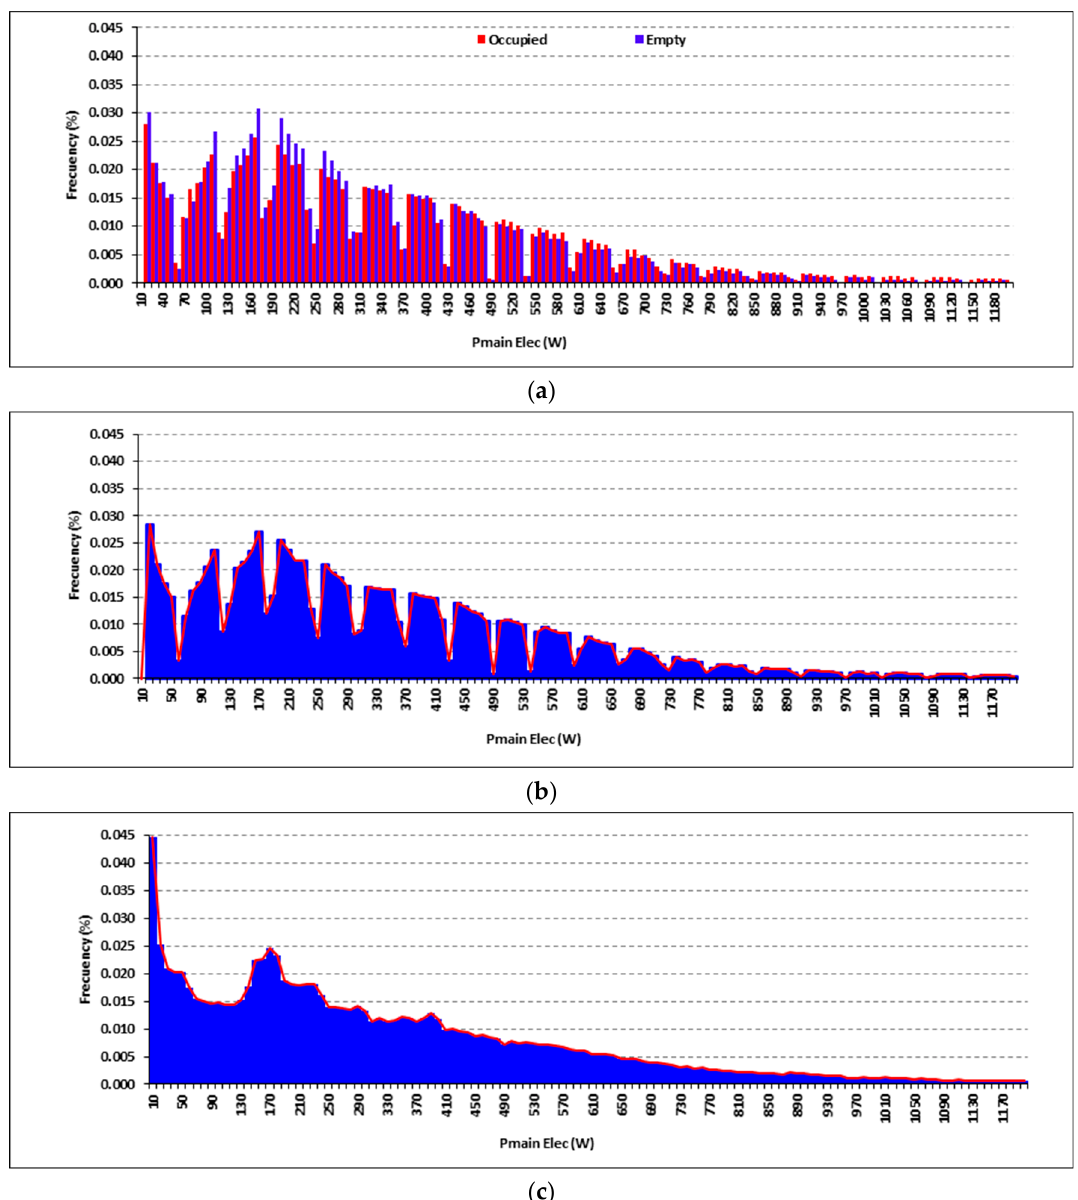
Figure 5. Histograms based on electricity consumption: ( a ) histogram of the electricity consumption assuming that the building was occupied when gas and water were being consumed, and the building was empty when the mechanical ventilation system was off and gas and water were not being consumed; ( b ) histogram of the total electricity consumption; ( c ) histogram of the total electricity consumption based on two hour moving averages.